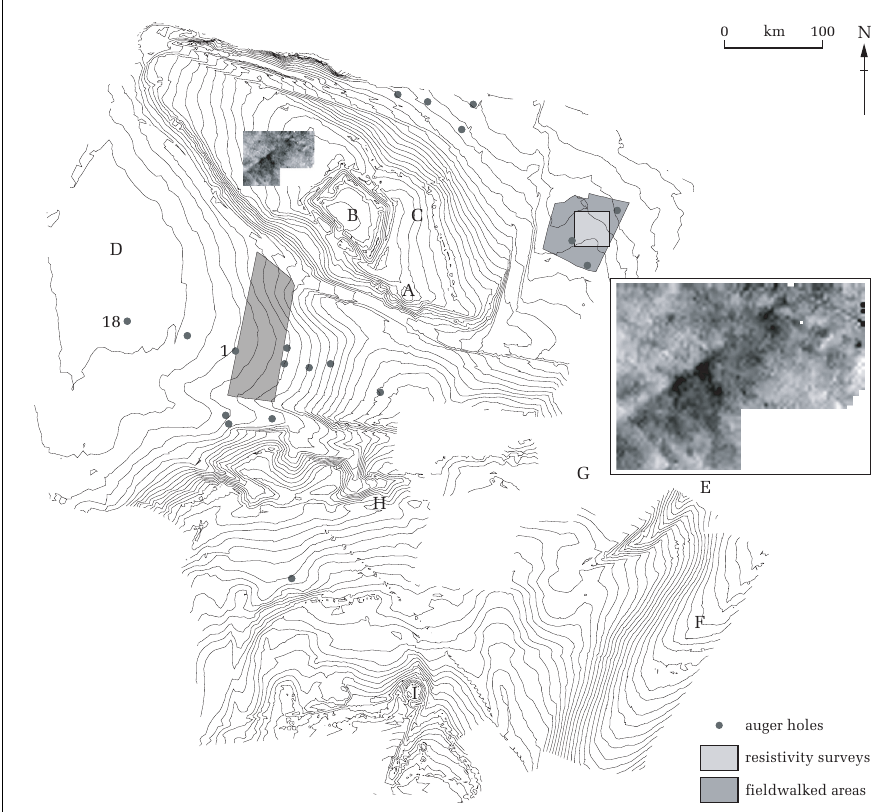
Figure 5 The topography of the site at Noviodunum as revealed by survey up to the end of the 2002 field season: (A) the late-Roman tower; (B) the Ottoman fortress; (C) the Roman fortress; (D) possible location of a harbour; (E) part of the outer defences of the civil settlement; (F) valley southeast of the main site; (G) modern quarry; (H) area of the civil settlement; (I) probable burial mound of unknown date that has been remodelled and used as a military command and control point for twentieth-century slit